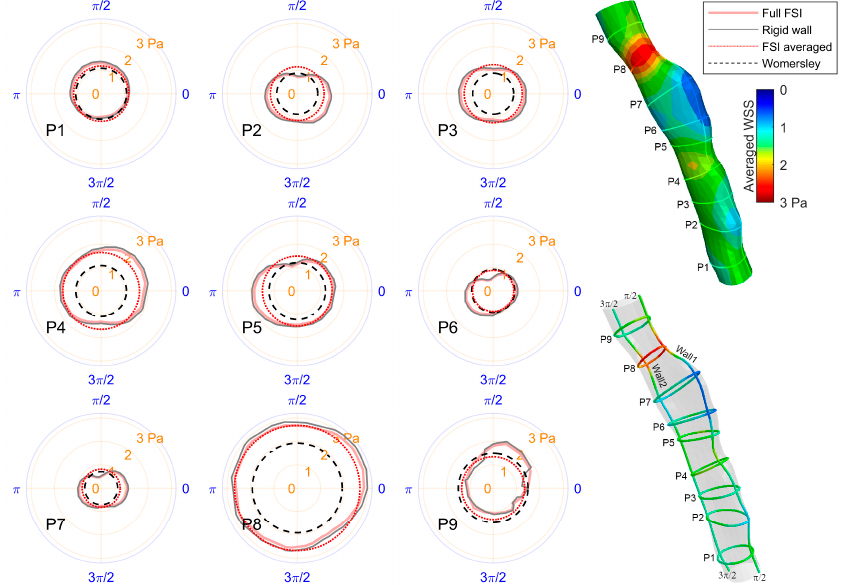
Figure 14. Polar representation of the time-averaged WSS computed from the full FSI, rigid wall, and Womersley models for nine Womersley cutting paths defined from slice 2.